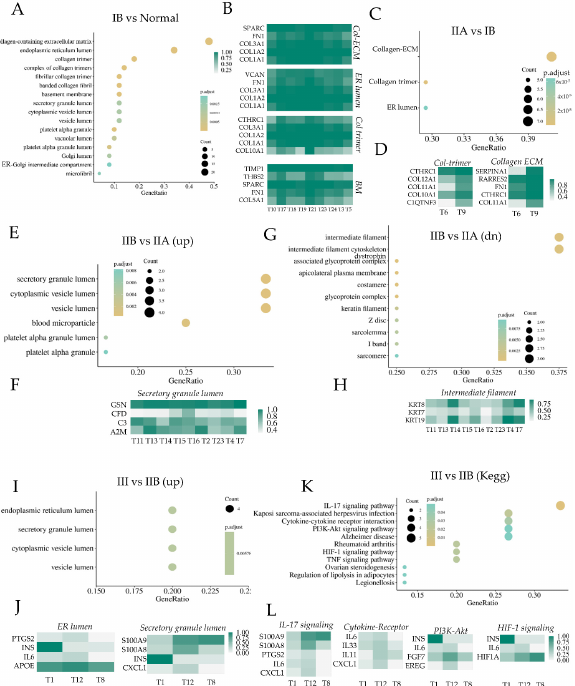
Figure 3. Pancreatic ductal cell carcinoma progression is accompanied by changes in fibroblast phenotypes across cancer stages. ( A ) Gene ontology (GO) enrichment score in all fibroblasts at stage IB differentially compared to fibroblasts from a normal pancreas; top differentially expressed genes in chosen GOs shown for fibroblasts from all patients at stage IB shown in ( B ). ( C ) GO enrichment score in all fibroblasts at stage IIA differentially compared with stage IB; top differentially expressed genes in chosen GOs shown in ( D ). ( E – H ) GO enrichment score for upregulated ontologies in fibroblasts at stage IIB compared to stage IB ( E ), and for downregulated ontologies ( G ); top differentially expressed genes for chosen upregulated or downregulated GOs in IIB vs. IIA shown in ( F , H ), respectively. ( I – L ) GO ( I ) and Kegg ( K ) activation score for upregulated gene sets in fibroblasts at stage III compared to IIB; top differentially expressed genes for samples obtained from patients at stage III shown for chosen GOs ( J ) and Kegg pathways ( L ). For all the above differential gene expression analyses, the criteria used were: p -value ≤ 0.05, log2fc ≥ 1 for upregulated gene sets and log2fc ≤ − 1 for downregulated gene